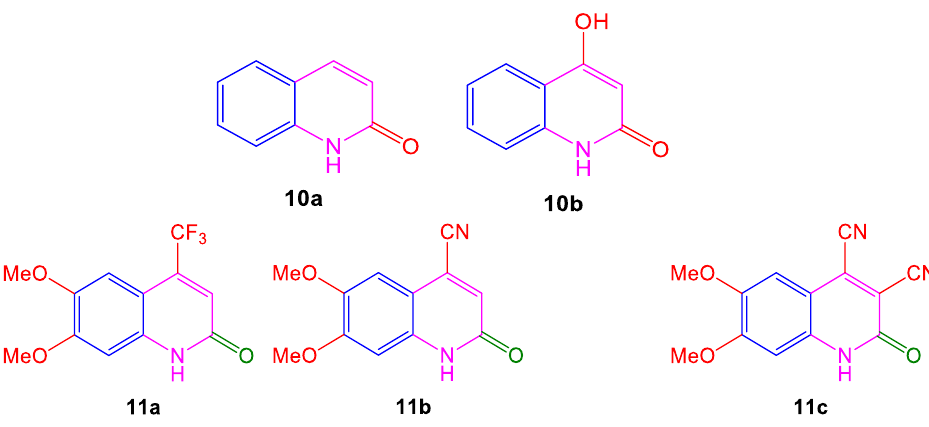
Figure 7. Structures of compounds ( 10a – b and 11a – c ).